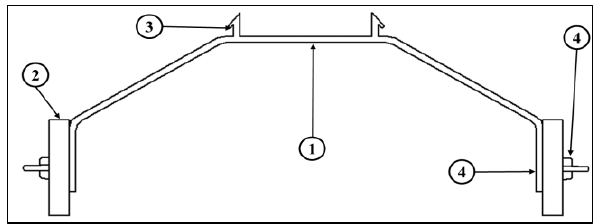
Figure 4: Sketch of the new landing gear.